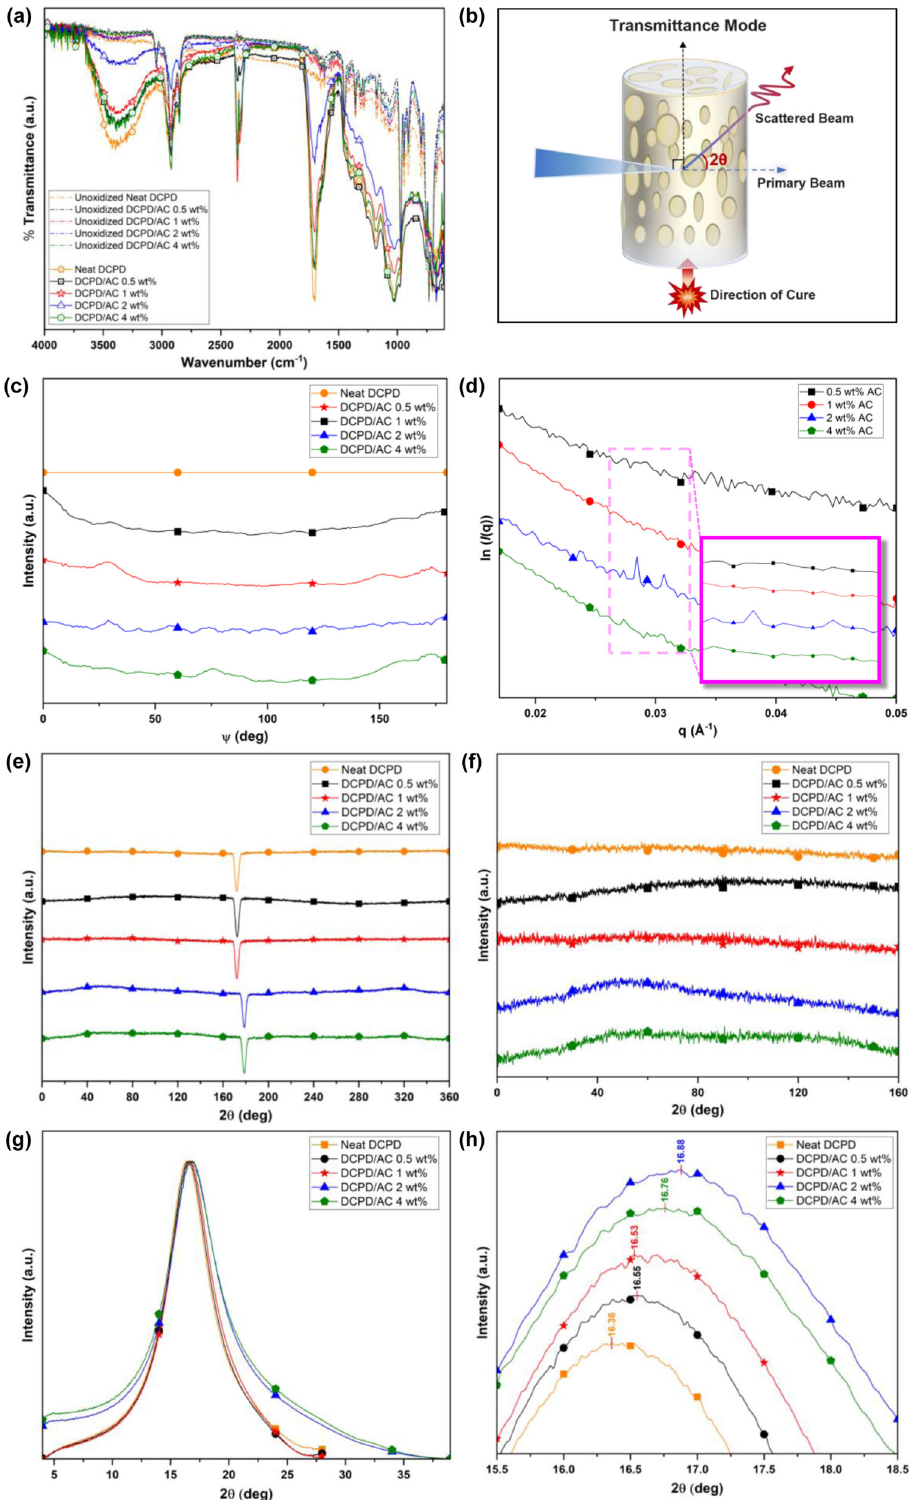
Fig. 6 An assessment of DCPD/AC foam crystal structures via the ATR-FTIR, SAXS, and WAXS analyses. a The normalized ATR-FTIR spectra of the prepared neat DCPD and DCPD/AC foams revealing the signi fi cantly less oxidized state of DCPD/2 wt% AC foam 8 weeks post-production. b A